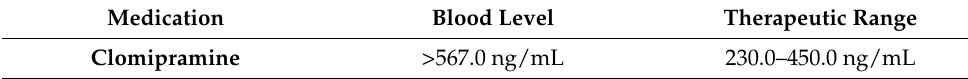
Table 3. Therapeutic Drug Monitoring of clomipramine at first